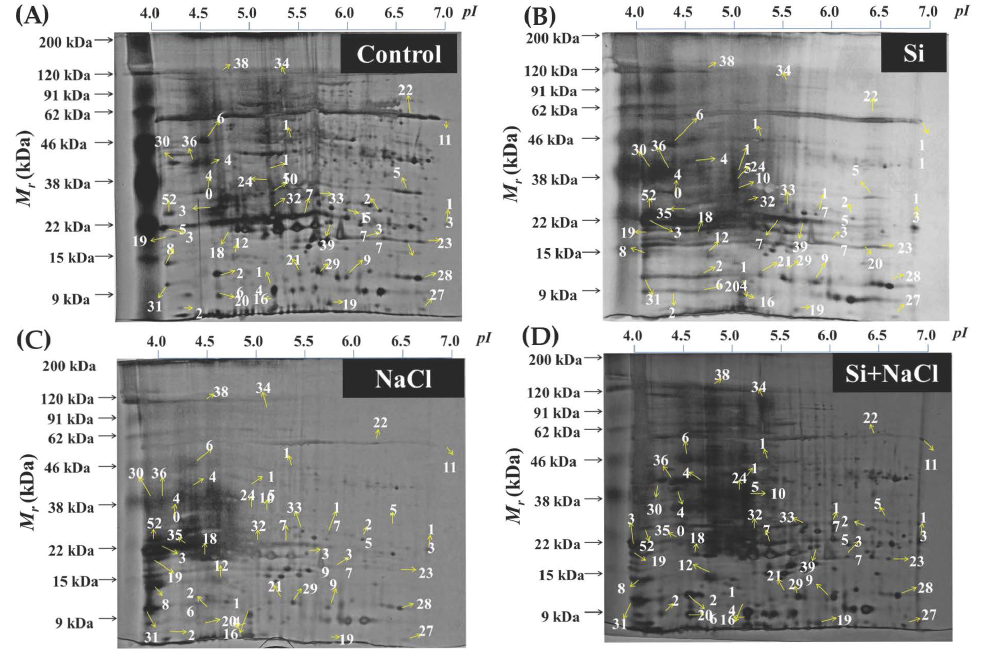
Figure 8. Representative images of two-dimensional gel electrophoresis (2-DE) gel of proteins extracted from the leaves Rosa hybrida ‘Rock Fire’ of control ( A ), Si ( B ), NaCl ( C ) and Si+NaCl ( D ) treatments, respectively. Differentially-expressed spots excised for the identification of the proteins by matrix-assisted laser desorption/ionization time-of-flight mass spectrometry (MALDI-TOF MS) are marked by the arrows.